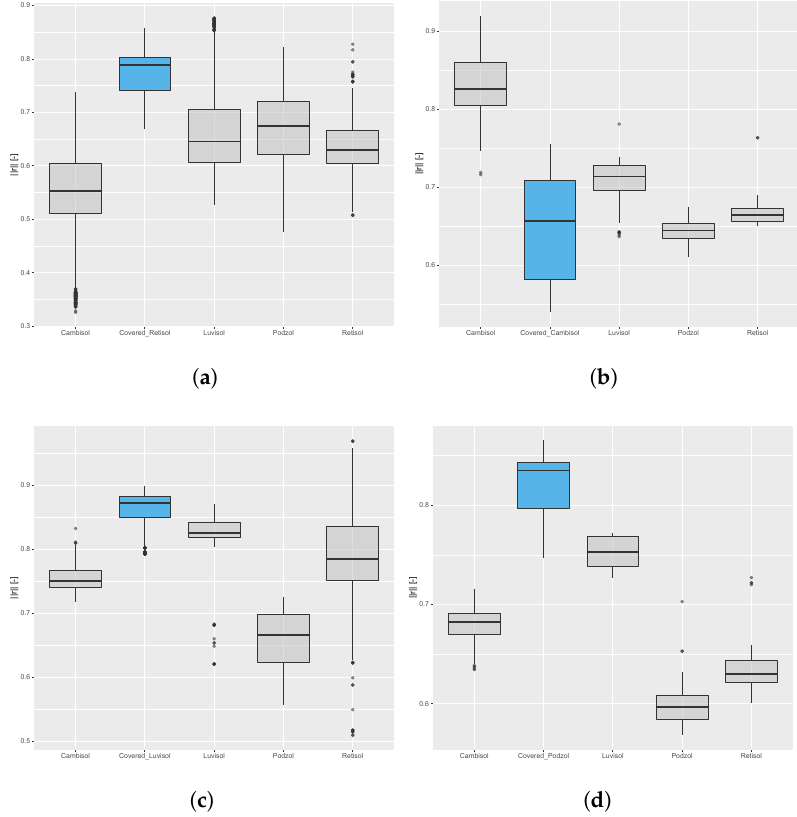
Figure 11. Box plots comparing || r || covered parcels to those of uncovered parcels planned for the same crop. Blue boxes reflect covered parcels. ( a ) Maize (400 spectra per boxplot), ( b ) Carrots (150 spectra per boxplot), ( c ) Broccoli (200 spectra per boxplot), ( d ) Cauliflower (50 spectra per